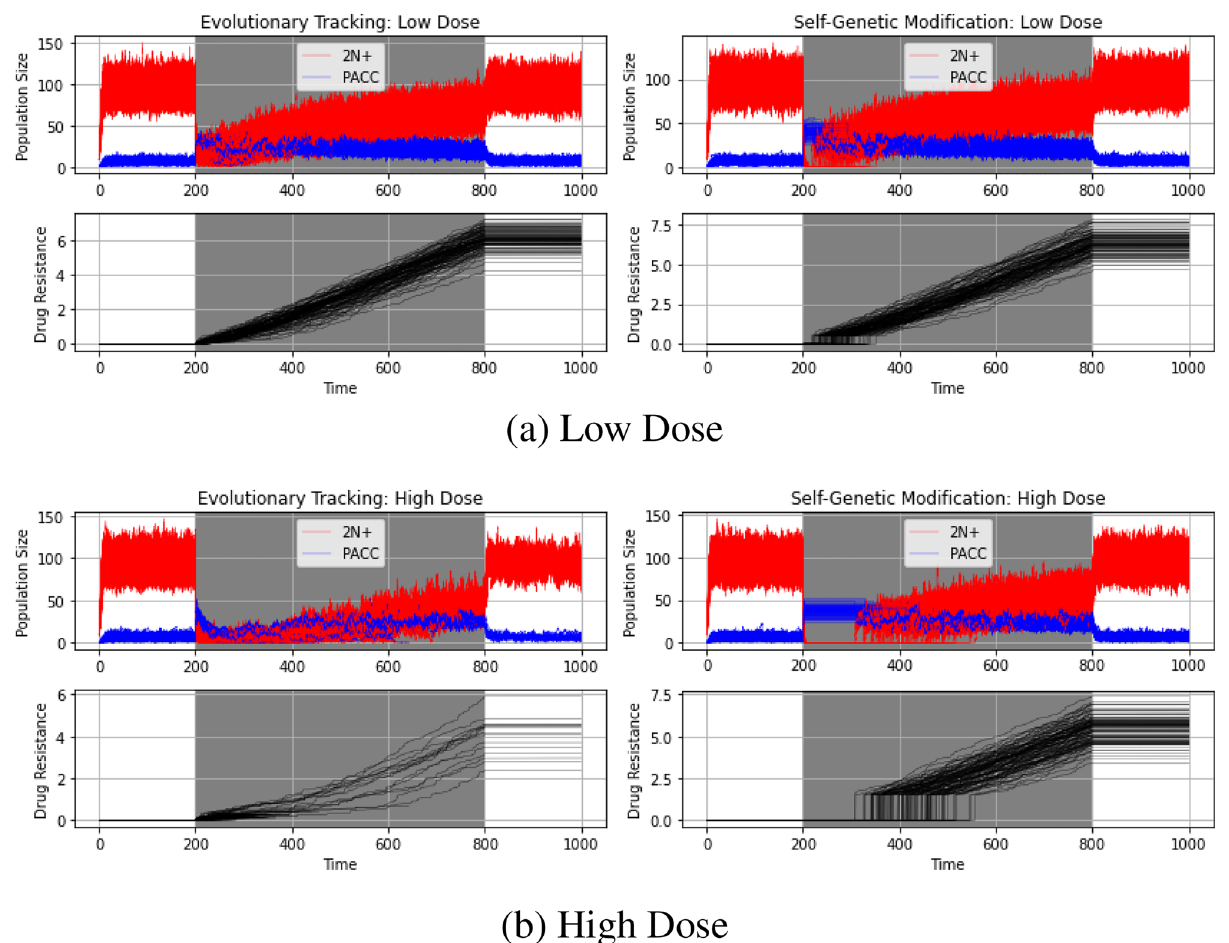
Figure 4. Low dose ( a ) and high dose ( b ) continuous therapy under evolutionary triage and self-genetic modification. The higher the dose of therapy, the longer cells remain in the stable PACC state under SGM. Under ET, all populations avoid extinction under low dose therapy, but the vast majority go extinct when exposed to a high dose of therapy.